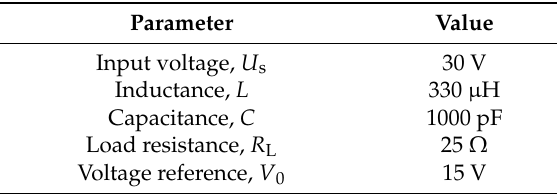
Table 1. Parameters of the converter.